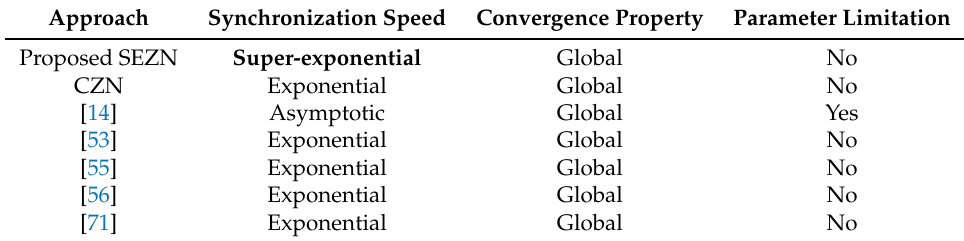
Table 5. Comparisons among different approaches for synchronization of chaotic systems.